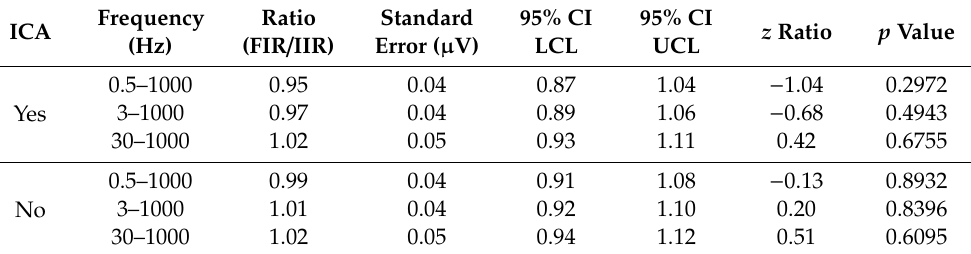
Table 4. Estimated contrasts of filter class (FIR / IIR).